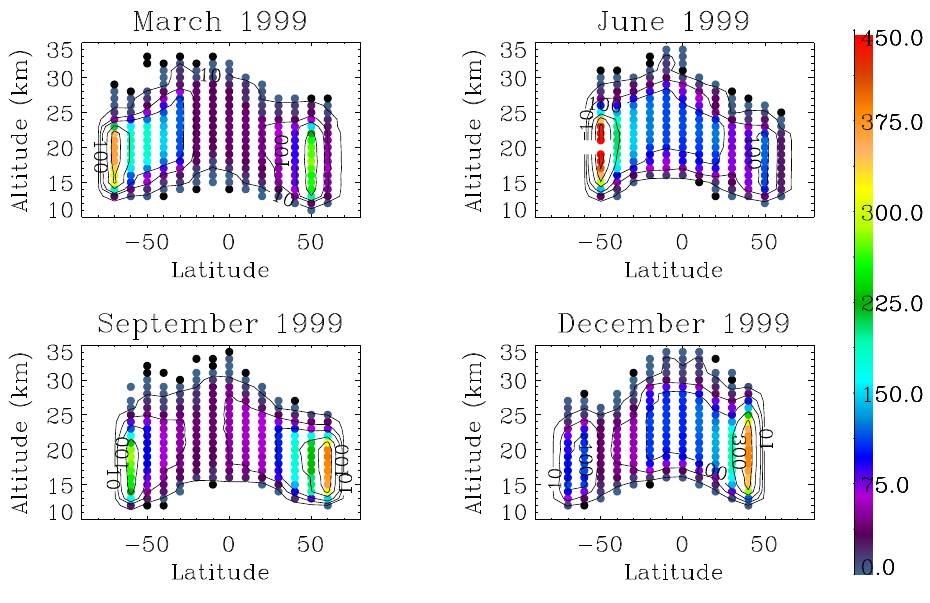
Fig. 16. Locations of SAGE II measurement events in March, June, September, and December 1999. The square marks the approximate location of Laramie/Wyoming (41 ◦ N, 105 ◦ W)